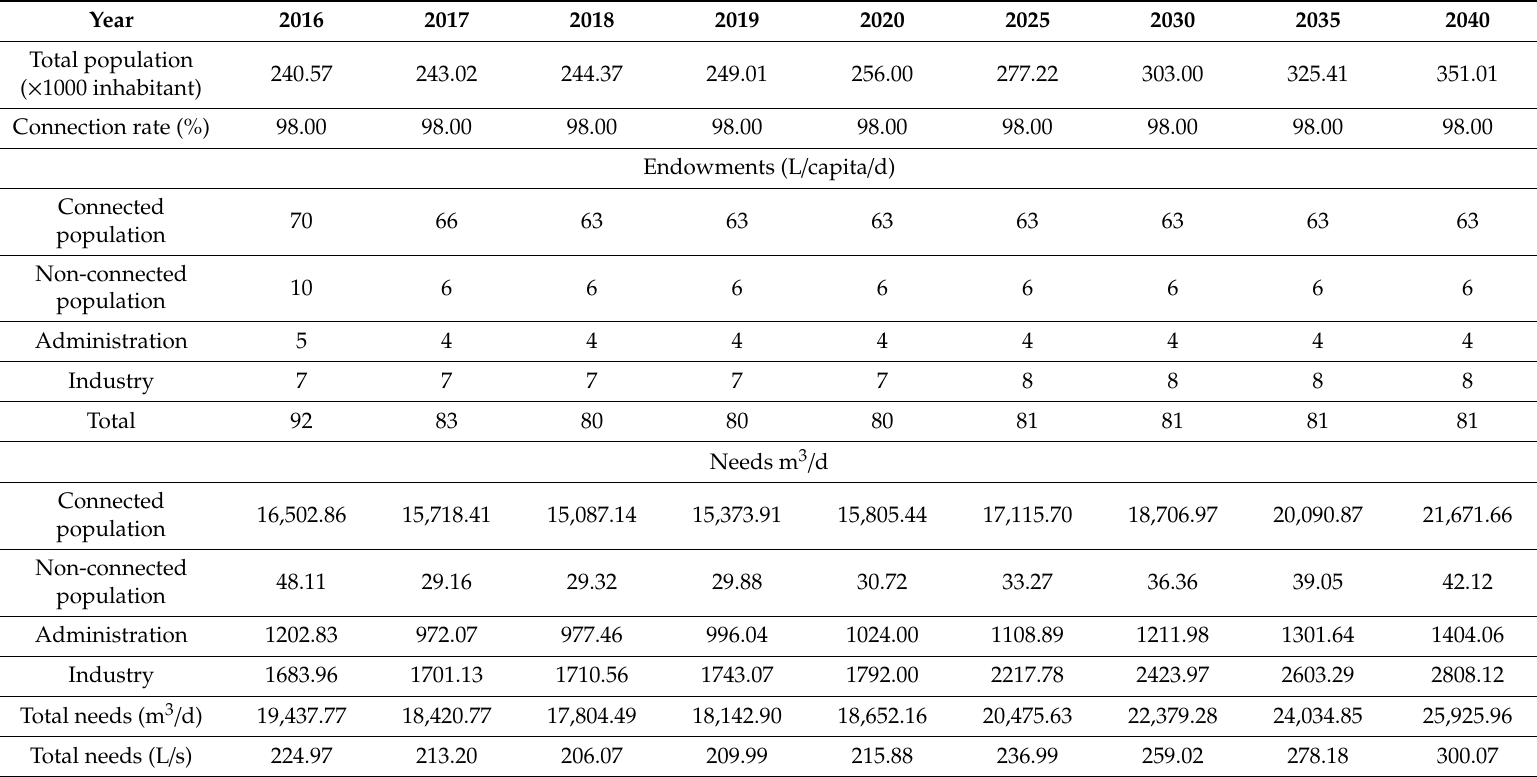
Table 2. Estimation of drinking water needs in Taourirt